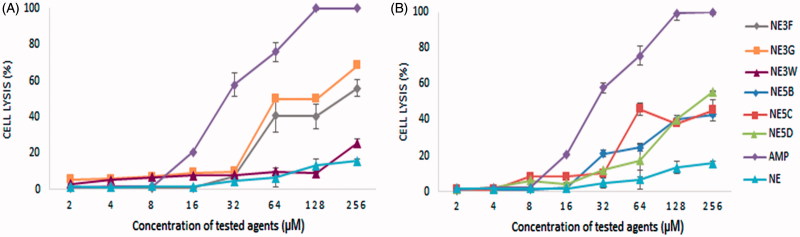
Haemolysis caused by different agents: amphotericin B (AMP) and nanoemulsions containing inhibitors. (A) NE-3F, NE-3G, NE-3W, AMP, and NEs; B. NE-5B, NE-5C, NE-5D, AMP, and NEs. (B) Haemolysis was determined by an absorbance reading at 540 nm and compared to haemolysis achieved with 1% Triton X-100 (reference for 100% haemolysis). Values are expressed as mean ± standard deviation (n = 3).